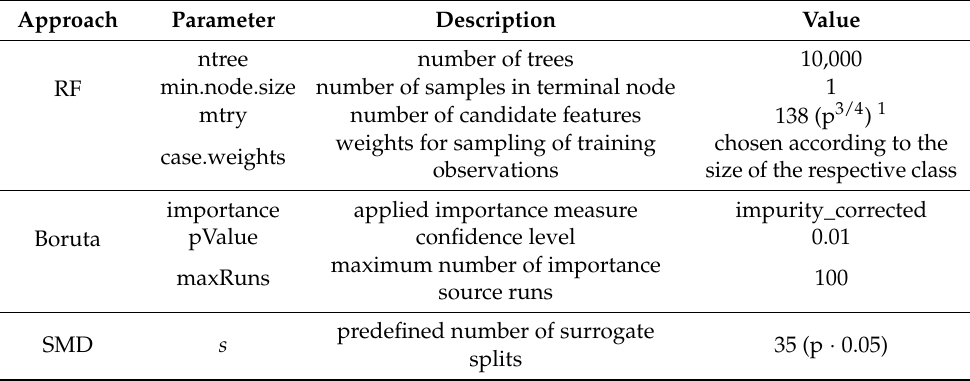
Table 5. Parameters used for the RF-based approaches with p representing the total number of